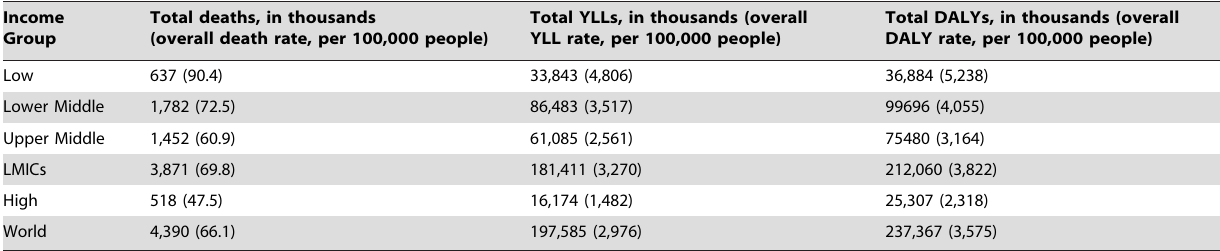
Totals and rates of death, YLLs, and DALYs by income group Income Group